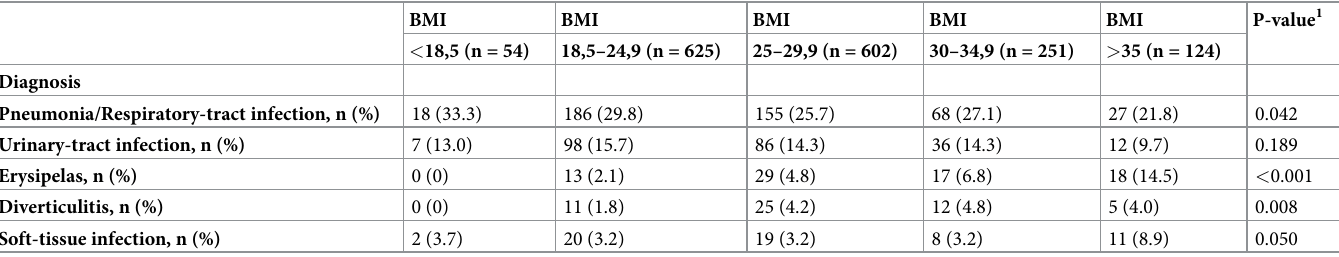
Table 2. Prevalence of different diagnoses by BMI-group.